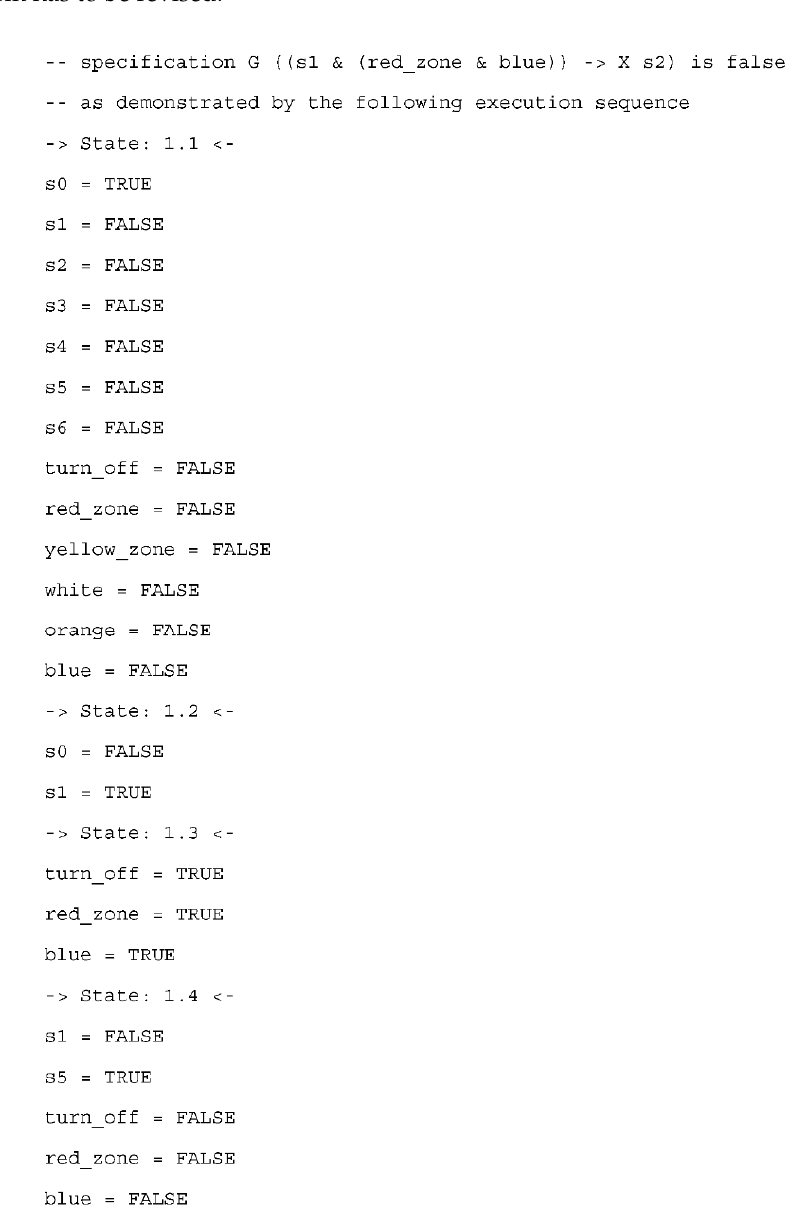
Figure 9. Generated counterexample for a normal mode with blue uniform in the red zone leading to safety mode and turning off signal leading to off mode.